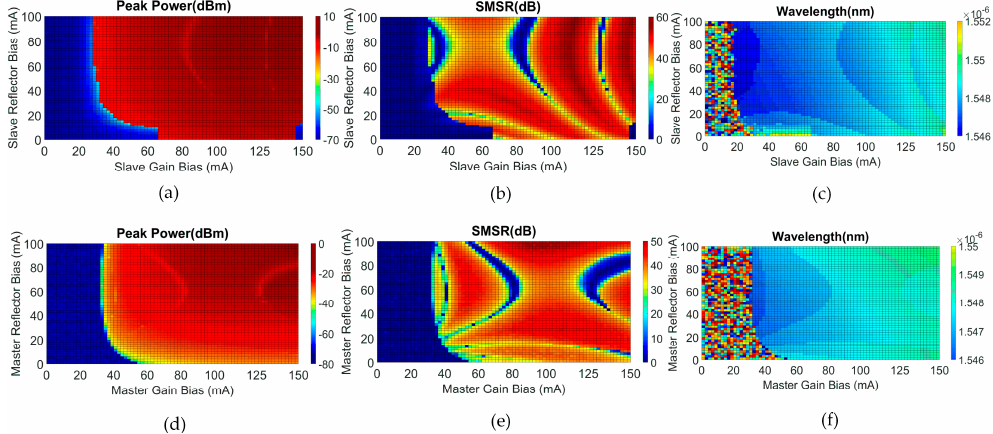
Figure 4. Contour plots of varying SG, SR bias currents and observing the following parameters: ( a ) slave peak power of the main mode; ( b ) slave SMSR of the output modes of the PIC; ( c ) slave emission wavelength of the main mode; and varying MG, MR bias currents and observing the following parameters: ( d ) master peak power of the main mode; ( e ) master SMSR of the output modes of the PIC and ( f ) master emission wavelength of the main mode.